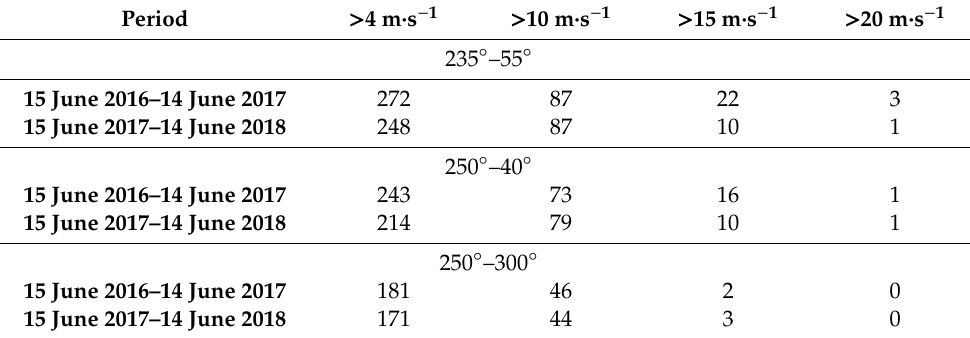
Table 2. Number of days with wind speeds allowing aeolian transport in the measuring years.